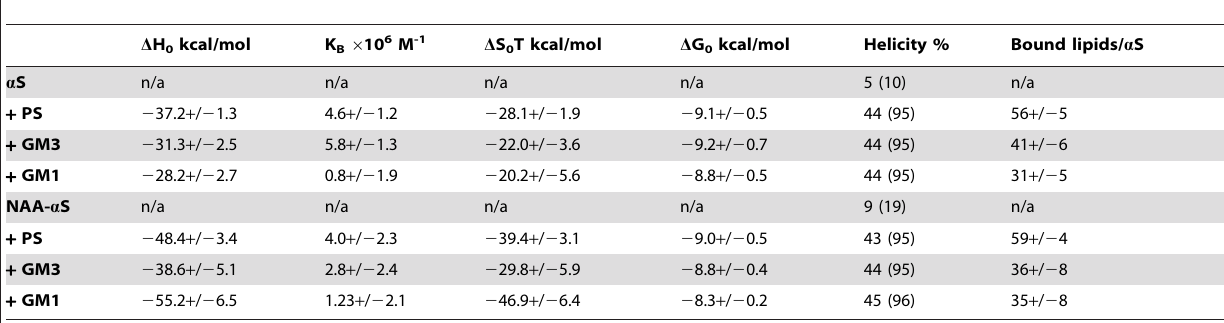
Table 1. Thermodynamic and structural parameters for NAA- a S and a S upon SUV titration.